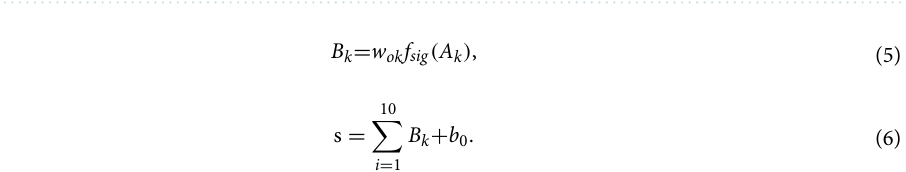
Figure 3. Processes of